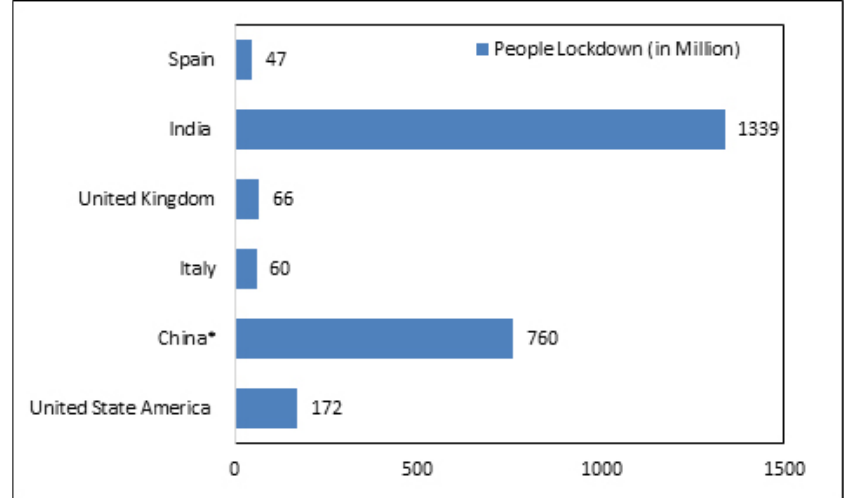
Fig.2. Number of people lockdown in different countries due to COVID-19 outbreak. (*During COVID 19 breakout in China) (Source: Statista, 3 April 2020)